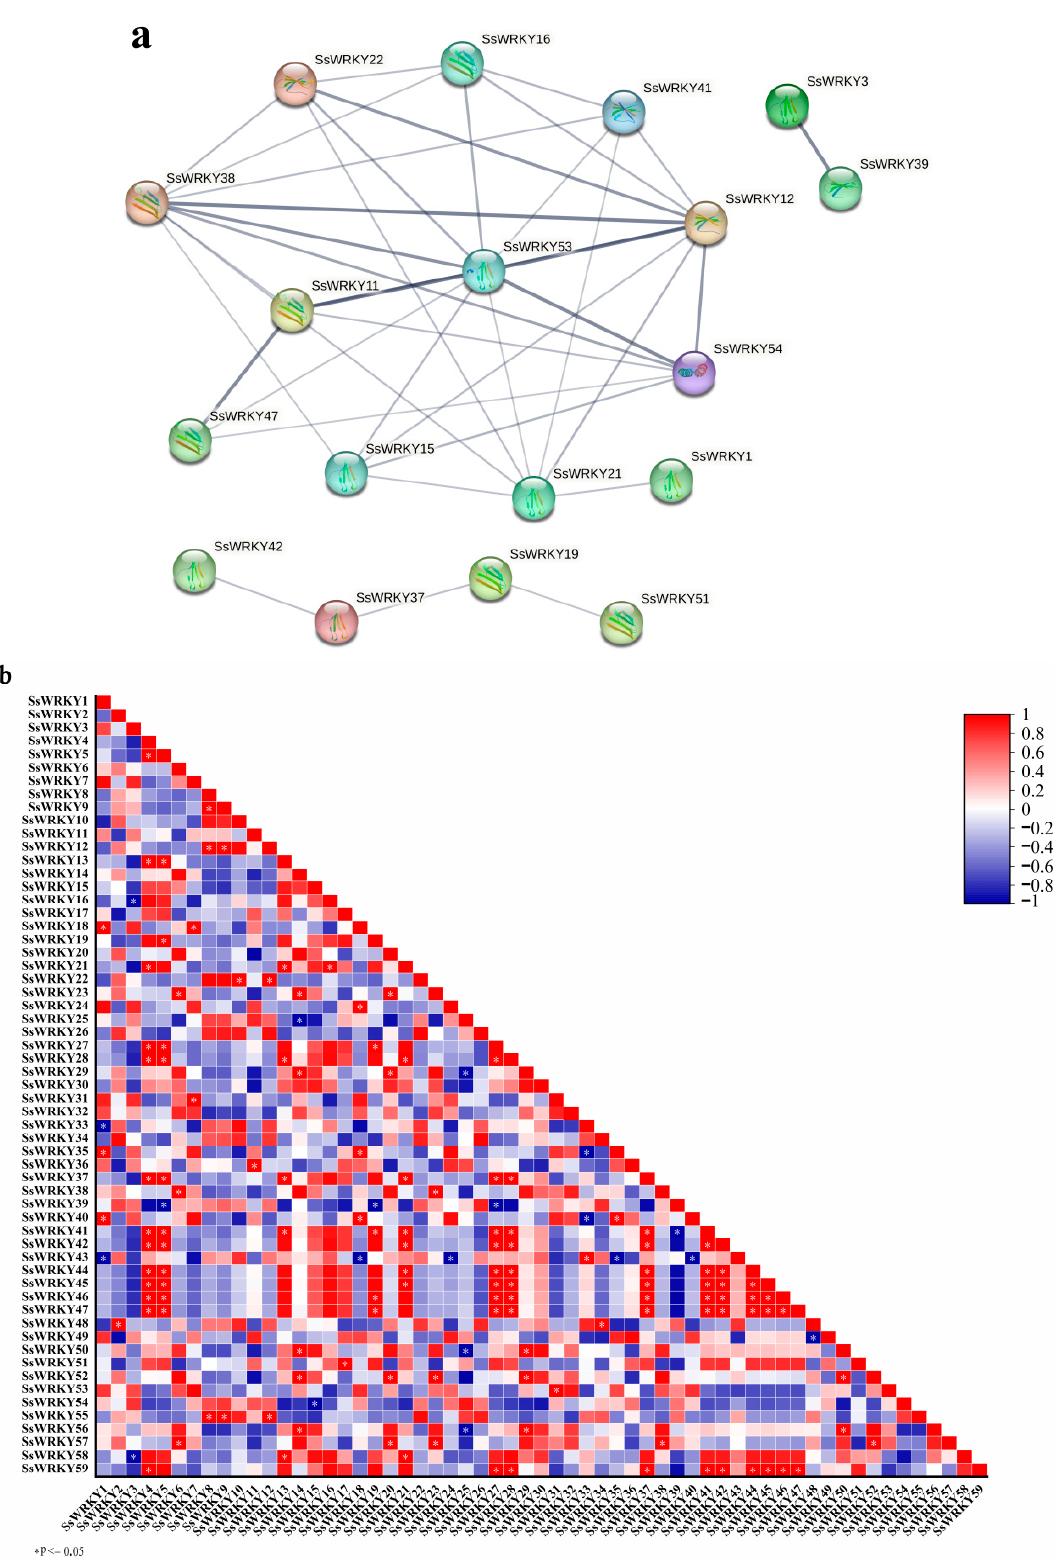
Figure 7. Functional interaction network diagram of SsWRKY protein and co-expression of SsWRKY genes. ( a ) Interaction network diagram of SsWRKY proteins. The thicker the gray connecting line, the stronger is the predicted interaction between the two proteins; ( b ) co-expression analysis of SsWRKY genes.* p < 0.05.